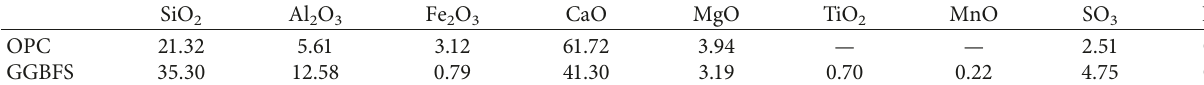
Table 1: Chemical composition of OPC and GGBFS (wt.%).